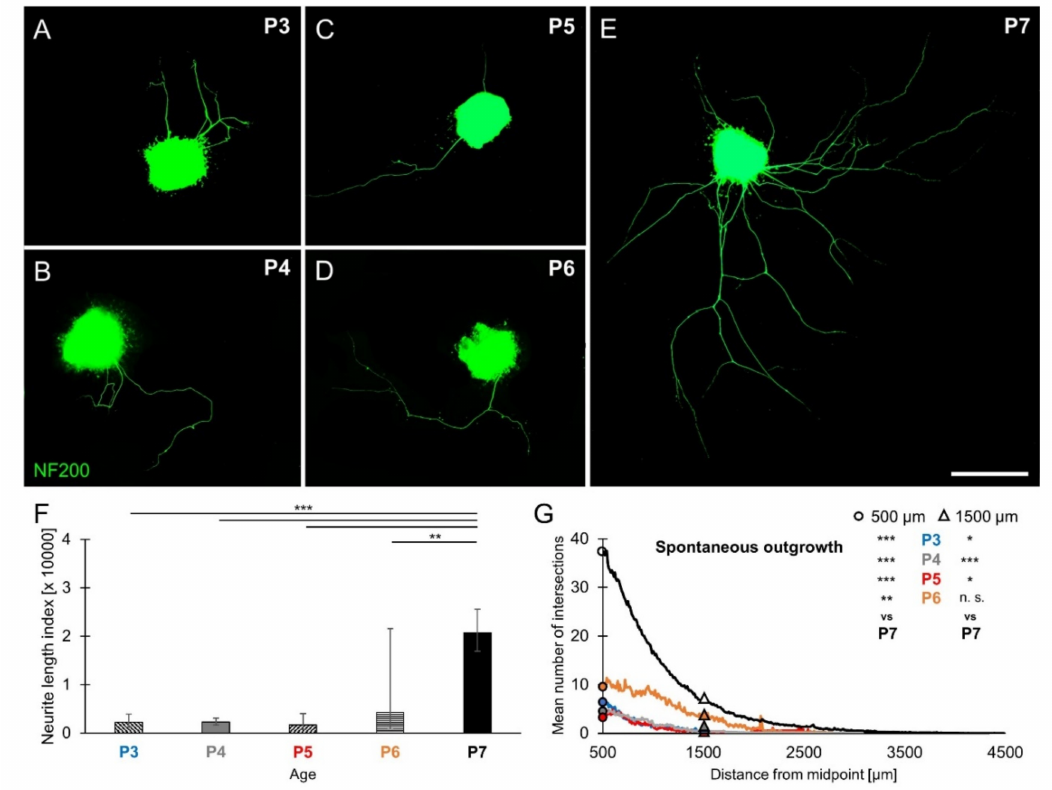
Figure 1. Spontaneous neurite outgrowth in spiral ganglion explants (SGEs) from P3 to P7 mouse cochlea. P3–P7 SGEs were cultured in medium devoid of neurotrophic supplements. After 4 days in vitro (DIV), SGEs were fixed and stained for NF200. Neurite outgrowth was quantified and expressed as neurite length index (NLI) and the number of extending neurites was approximated by the mean number of intersections. ( A – E ) Images of NF200-immunolabeled (green) P3–P7 SGEs are shown. Scale bar (A–E): 500 µ m. ( F ) Neurite outgrowth was quantified. Bars represent geometric mean NLI values in µ m and error bars depict ± the upper and lower 95% confidence intervals for the mean. ( G ) To compare neurite number and extension, histograms of the mean number of intersections were plotted as a function of the distance from the midpoint of the SGE. The mean (arithmetic mean) numbers of intersections at 500 µ m (circles) and 1500 µ m (triangles) distance from midpoint for the di ff erent age groups P3–P6 were statistically compared to P7 results; one-way ANOVA, Dunnett post-hoc test, n. s. = not significant ( p > 0.05), * p < 0.05, ** p < 0.01, *** p <